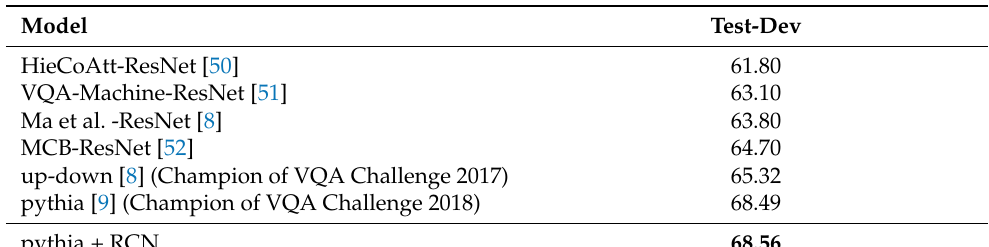
Table 1. Single-model VQA 2.0 performance in %. Based on the champion of the VQA challenge 2018, pythia, we insert an RCN block and train the model from scratch. Model